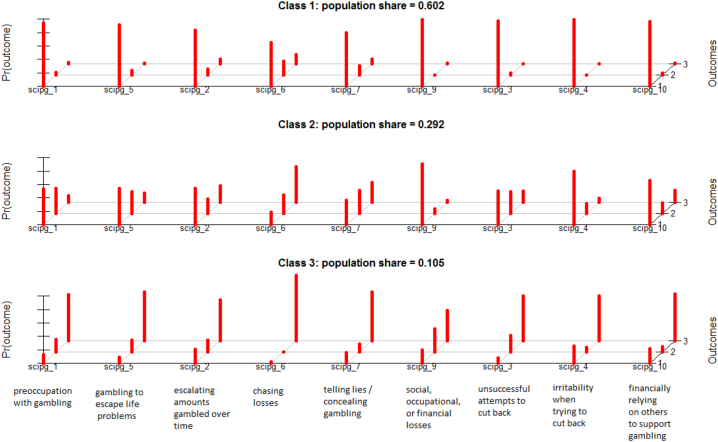
Distribution of individual SCI-GD responses in the three subgroups. Y-axis indicates the probability of a given individual in that subgroup endorsing each score on the item. 1 = criterion absent; 2 = criterion is partially met; 3 = criterion fully met. The item ‘chasing losses’ was particularly strongly endorsed in the problem gamblers group compared to the other items.